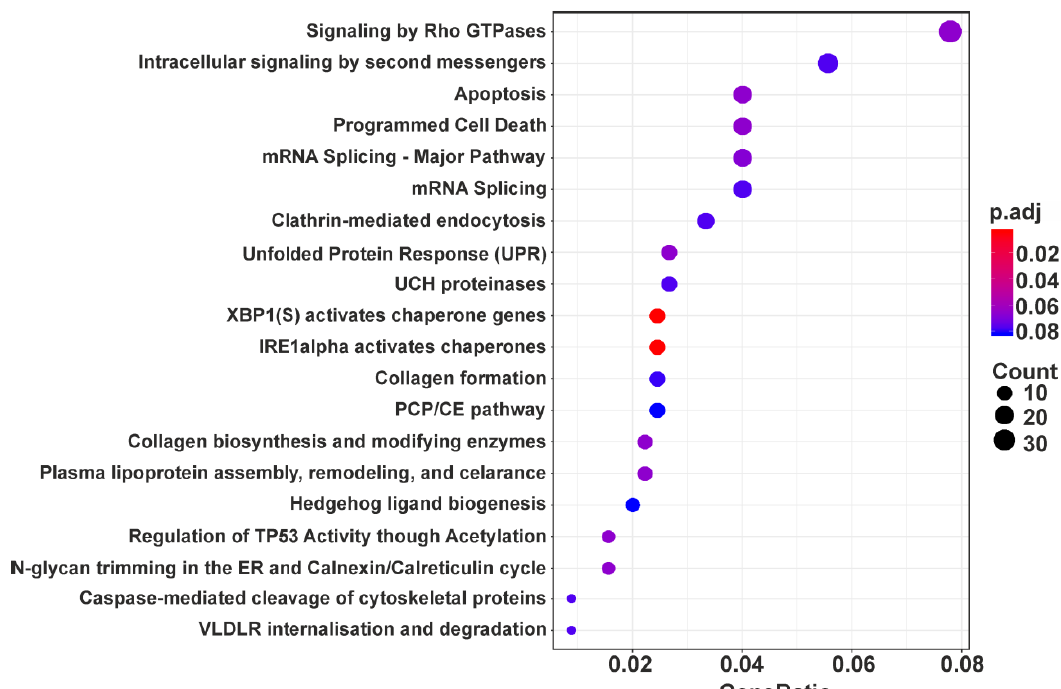
Figure 3. Dotplot enrichment map showing cellular pathways associated with up-regulated DEGs. The top 20 by DEG counts are presented from 38 pathways with p.adj values <0.1 found for the above DEGs (Supplementary Table S7). The color of the dot depends on the value of p.adj, and its size is determined by the number of DEGs related to the respective pathway in the analyzed set of DEGs (map color keys along with dot size ones are shown on the right).